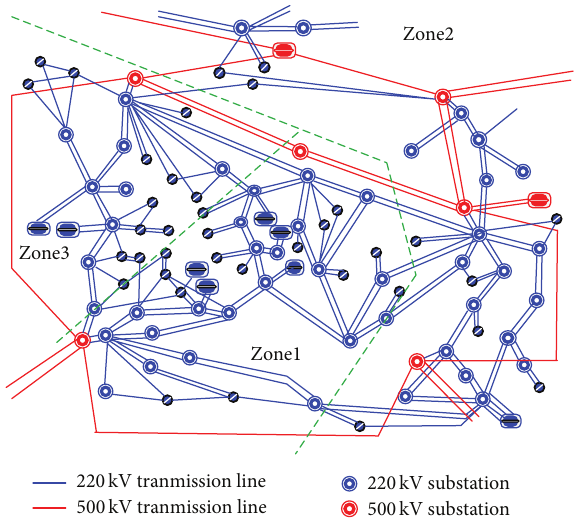
Figure 3: Geographical wiring layout of TJ220